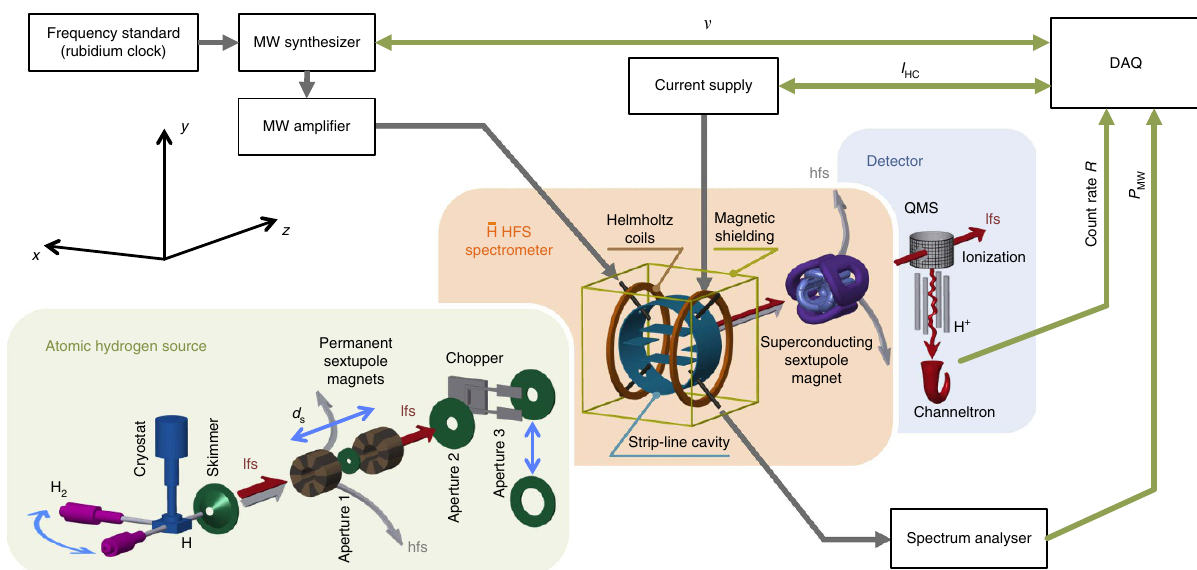
Figure 2 | Atomic hydrogen beam setup. Illustration of the three main components of the Rabi-type experimental setup (not to scale). Green panel: the source of cold, polarized and modulated atomic hydrogen. Orange panel: the hyperfine spectrometer of ASACUSA’s antihydrogen experiment. Blue panel: the detector. The source consists of a microwave-driven plasma for dissociation of H 2 , a cryostat for cooling the atomic hydrogen beam in a PTFE tubing, two permanent sextupole magnets for polarization and velocity selection, and a tuning fork chopper for beam modulation. The hyperfine spectrometer consists of a state-conversion cavity of strip-line geometry and Helmholtz coils enclosed in a cuboidal Mu-metal shielding followed by a superconducting sextupole magnet for spin-state analysis. The detector employs a QMS for selective mass ¼ 1 ion (H þ ) counting after ionization. The count rate is acquired as a function of the driving frequency supplied to the